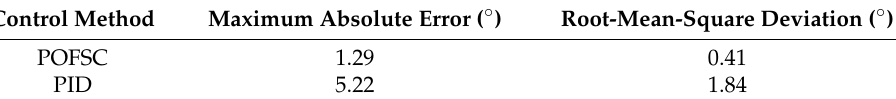
Table 9. Error comparison using the POFSC and PID for the shoulder joint (45°).